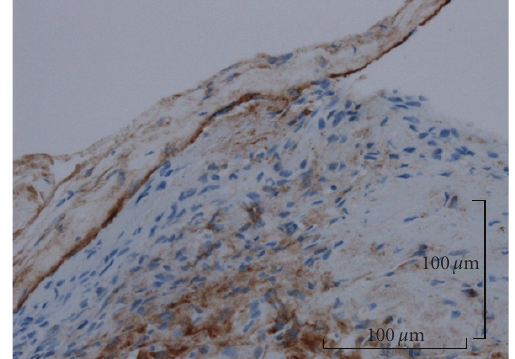
Figure 5: The endothelial cells of this lesion were reactive on immunohistochemical staining for Factor VIII related antigen, and Factor VIII related antigen was positive in the endothelial cells (Original magnification, × 16; Bar, 100 micrometer).